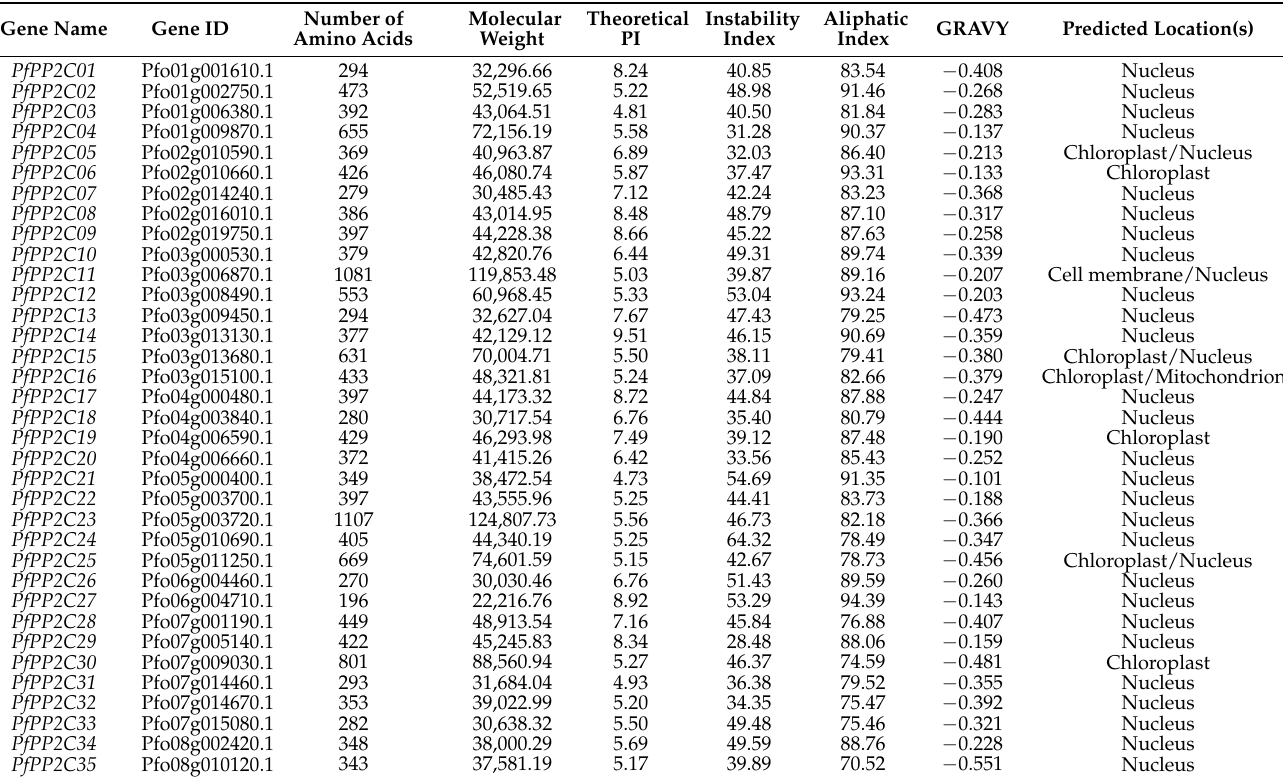
Table 1. Physicochemical properties of PP2C family members in P. Fortunei